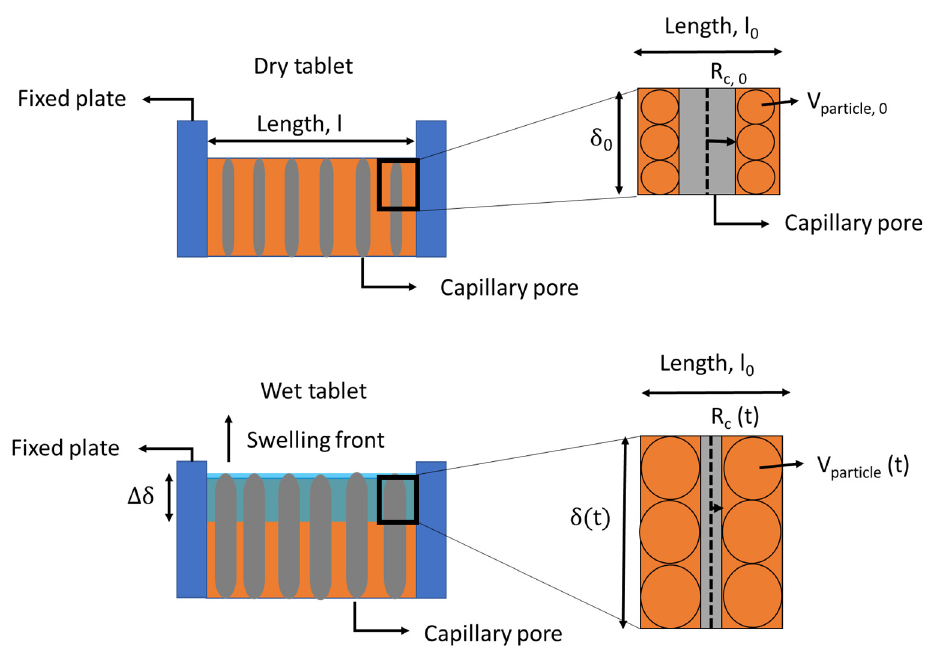
Figure 1. Schematics of the effect of matrix swelling on the internal pore structure considering restrained axial swelling. Adapted from: Markl et al. [20]—Open access.